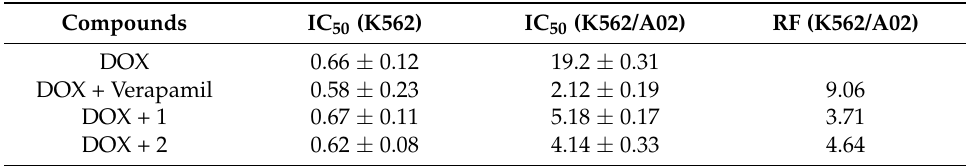
Table 2. Effects of compound 1 – 7 (10 μ M) on doxorubicin (DOX) cytotoxicity in K562 cells and